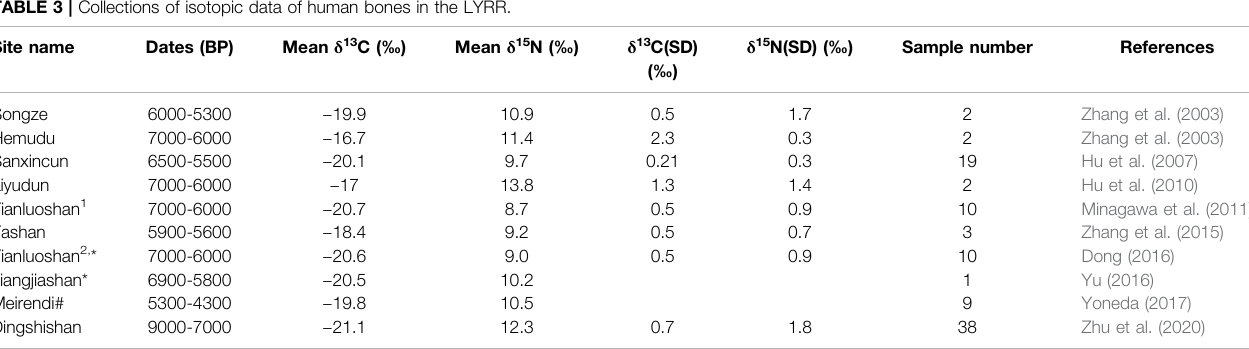
TABLE 3 | Collections of isotopic data of human bones in the